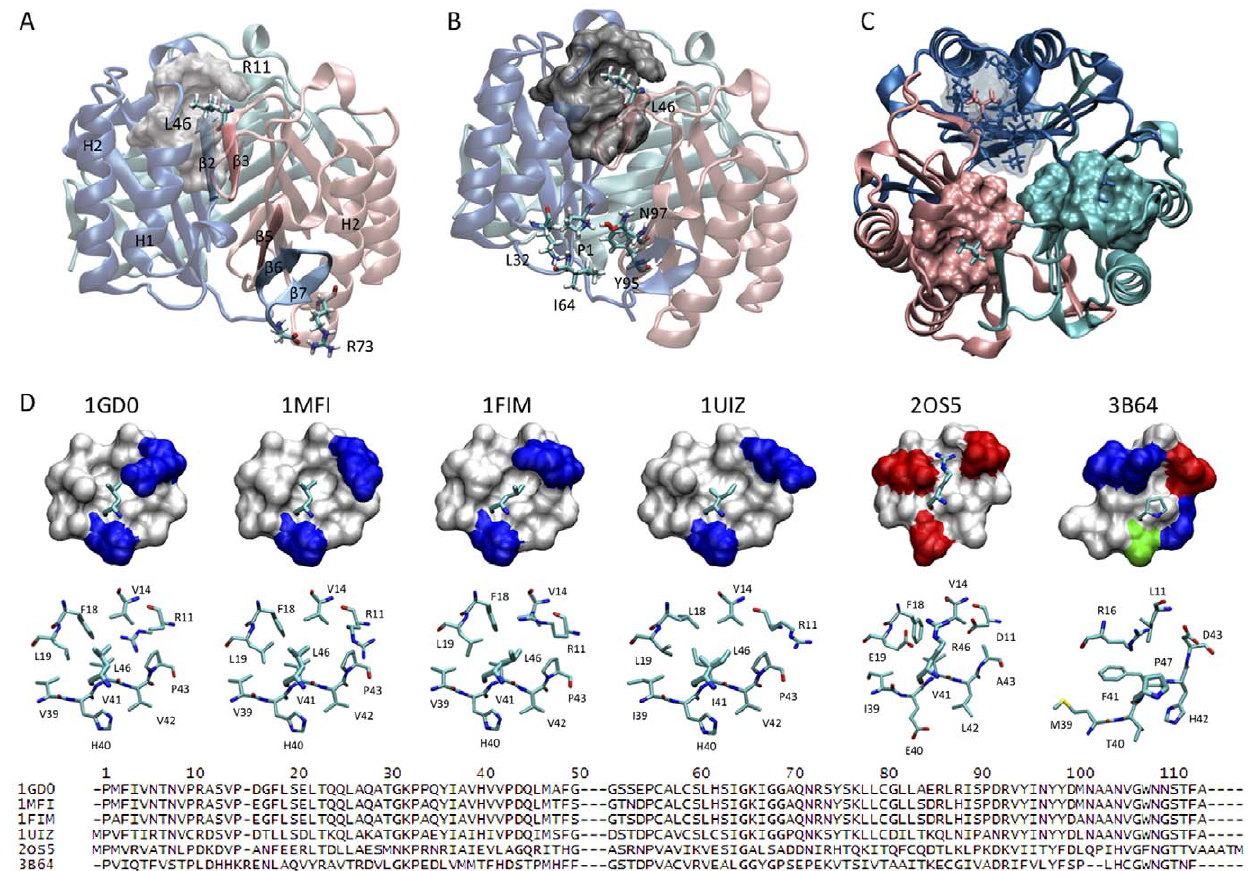
Figure 1. The Leu46 hydrophobic pocket is highly conserved across MIF species. The three MIF monomers are represented as cartoons and are colored in pink, cyan and blue. (A) Side view of the trimer illustrating the different intersubunit interactions. Two main regions within each monomer were shown to be responsible for the protein trimerization: each subunit interacts with one neighbouring monomer through tight interactions involving the inner b -strand ( b 3) and with the other neighbouring monomer though the C-terminal b -hairpin ( b 6 and b 7). The C-terminal b -hairpin comprises two major types of interactions: 1) intersubunit b -sheet, and 2) salt-bridge interactions. The b -strand b 3 contributes to trimer stabilization through two types of contacts: 1) intersubunit b -sheet formation, and 2) hydrophobic interactions between the side chain of Leu46 localized on the b -strand b 3 and a hydrophobic pocket from the adjacent monomer constituted by residues Arg11, Val14, Phe18, Leu19, Val39, His40, Val41, Val42, Pro43. (B) Side view of the trimer illustrating the distance between the Leu46 hydrophobic pocket and the enzymatic site. (C) Top view of huMIF showing the three hydrophobic pockets where Leu46 from adjacent monomers are packed. Each pocket is represented with the same color as the subunit it belongs to, Leu46 are represented as stick models licorice and colored with the same subunit color. Structural data according to Orita et al. [51], PDB code: 1GD0. (D) Hydrophobic pocket structure homology between different MIF species. Structural data were generated using the following PDB files: 1GD0 (human MIF, [51]); 1MFI (mouse MIF, [68]); 1FIM (rat MIF, [69]); 2OS5 ( Ancylostoma ceylanicum MIF, [70]); 3B64 ( Leishmania parasite MIF, [71]); 1UIZ ( Xenopus laevis MIF, [72]). Amino acids are represented on the figure with one-letter codes.